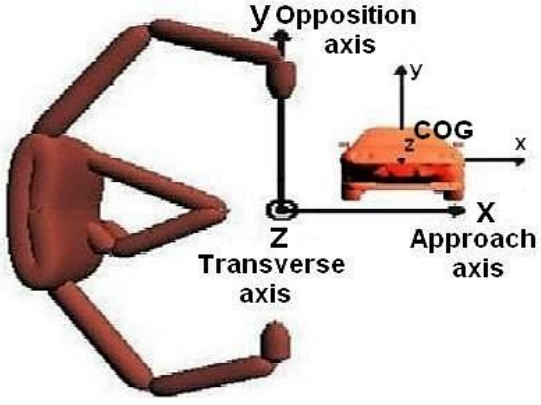
Figure 3. Approach of Hand towards an Object Model